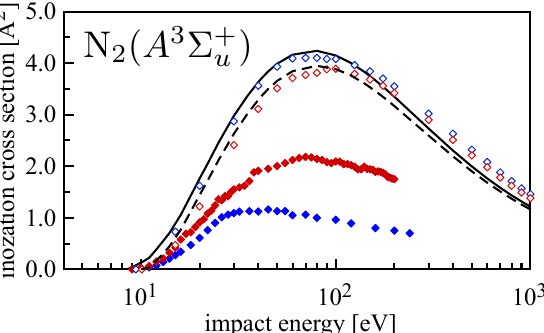
Figure 1. BEB cross sections for total ionization (solid lines) of N 2 ( A 3 Σ + u ) metastable [29], (dashed line) BEB cross section with B HOMO = 10.47 eV. CSP-ic results [23] for model A (blue open dia- monds) and model B (red open diamonds). Experiments: (close blue diamonds) [33], (close red diamonds)